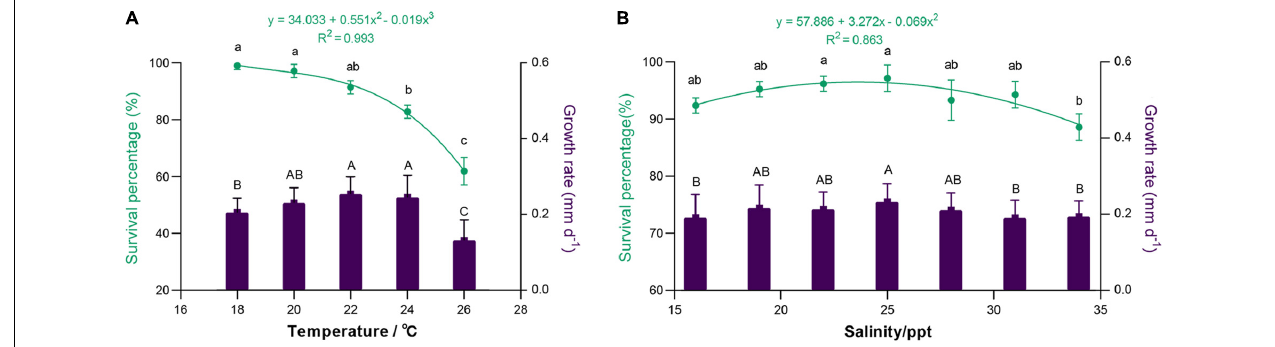
FIGURE 5 | Survival and growth of M. lateralis spat cultured at different temperatures (A) and salinities (B) . The green part indicates the survival percentage; the purple part indicates the growth rate. Different letters represent significant differences between different trials ( p <